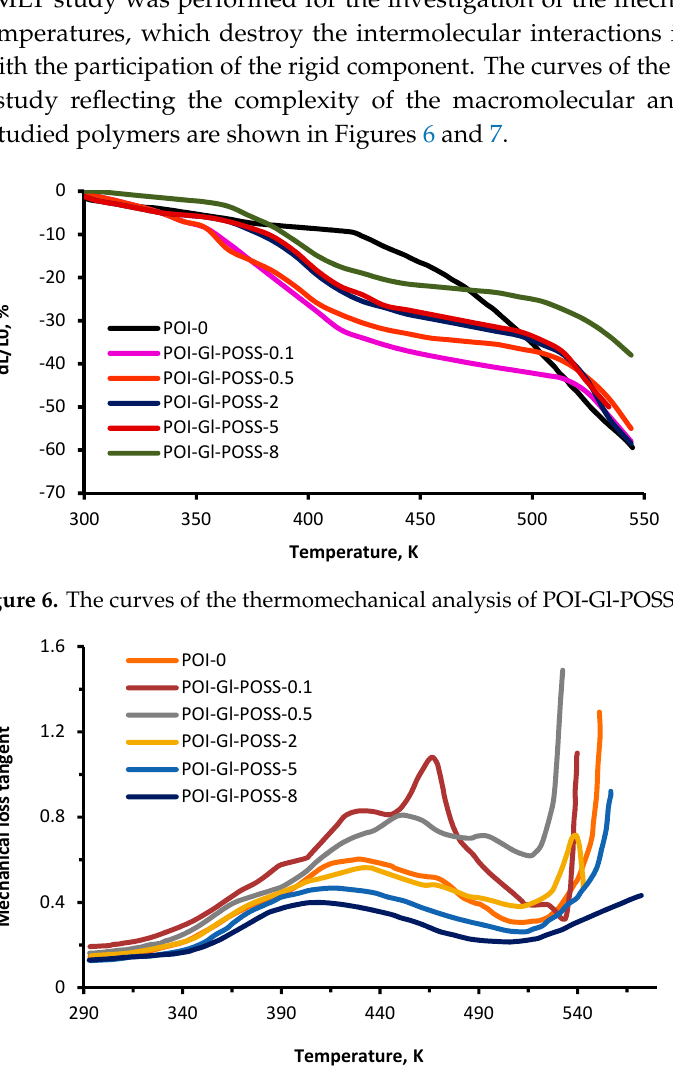
Figure 7. The temperature dependence of the mechanical loss tangent of POI-Gl-POSS.